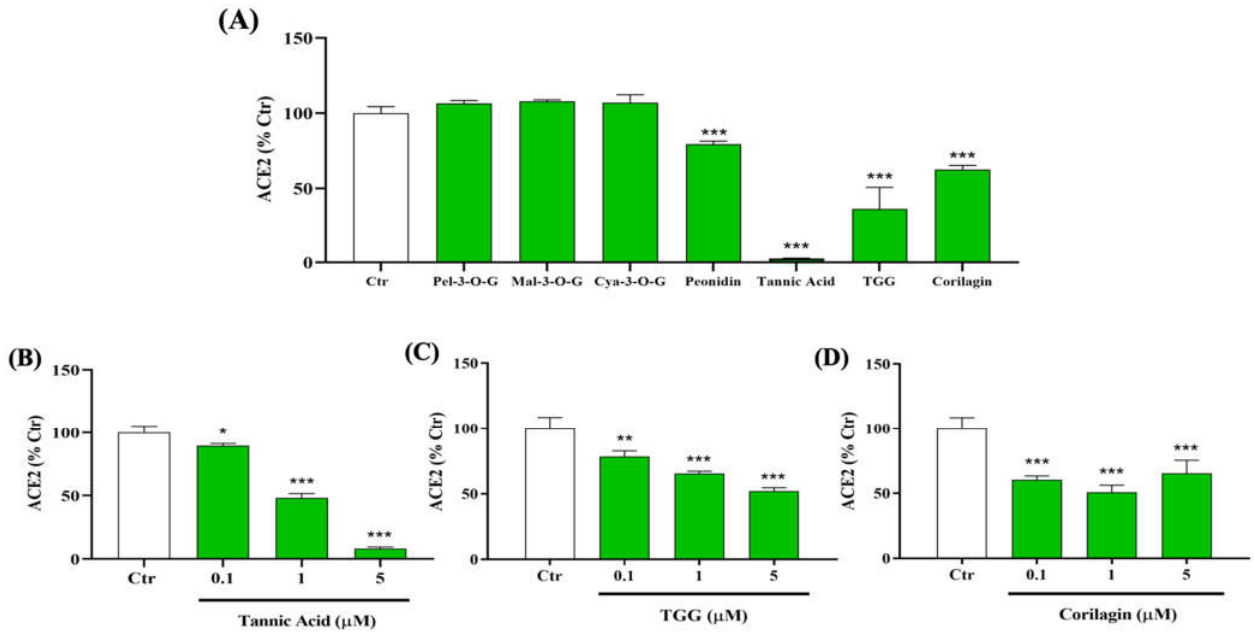
Figure 1. Inhibitory effects of different polyphenols on the interaction between SARS-CoV-2 spike protein receptor binding domain (RBD (N501Y)) and human angiotensin-converting enzyme 2 (ACE2). ( A ) 10 μM of pelargonidin-3-O-glucoside (Pel-3-O-G), malvidin-3-O-glucoside (Mal-3-O-G), cyanidin-3-O-glucoside (Cya-3-O-G), peonidin, tannic acid (TA), 1,3,6-tri-O-galloyl-β-D-glucose (TGG), and corilagin were tested to evaluate their ability to inhibit the binding of immobilized spike protein (0.5 μg/mL) to human, biotin-labeled ACE2 (0.25 μg/mL) by using an enzyme-linked immunosorbent assay (ELISA). Dose effect inhibition of 0.1, 1, and 5 μM ( B ) TA, ( C ) TGG, and ( D ) corilagin. The absorbance of ACE2 (0.25 μg/mL) at 450 nm was set to 100%. Results are expressed as mean ± SD (n = 3). Statistical analysis was performed using one-way ANOVA followed by the Tukey post hoc test with * p < 0.05, ** p < 0.01, *** p < 0.001 compared to ACE2 (0.25 μg/mL).